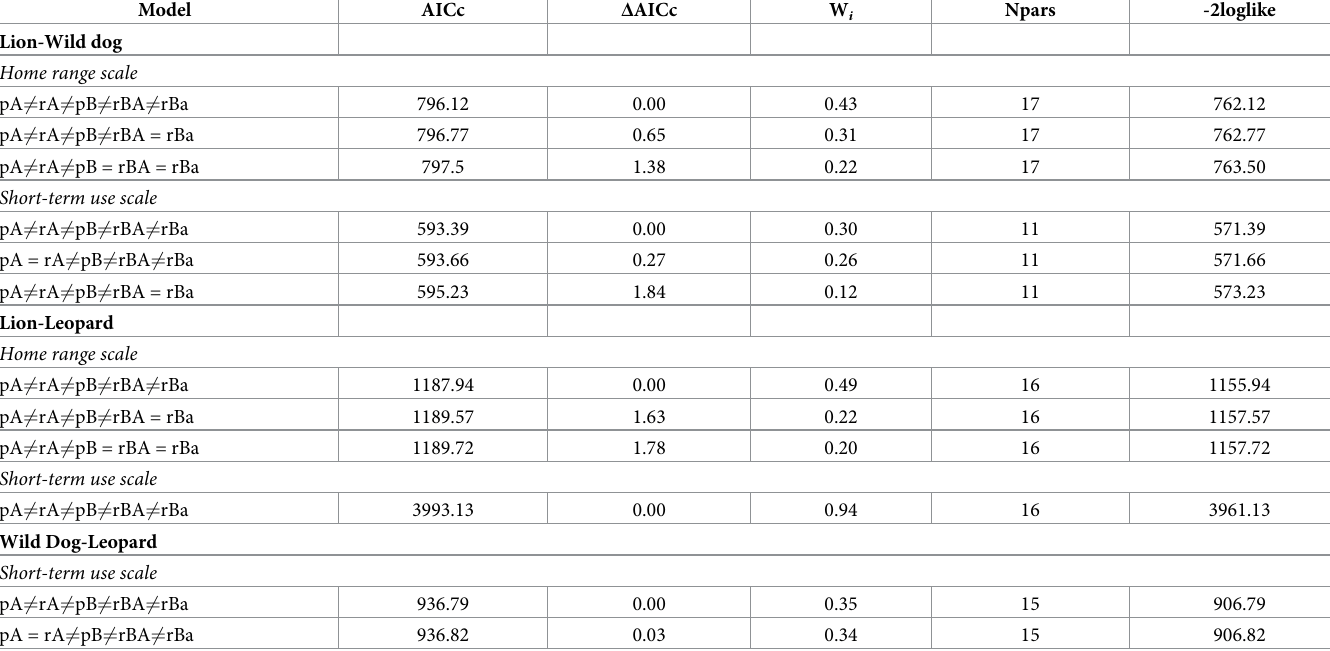
Table 3. Summary of co-occurrence model rankings used to evaluate the role of interspecific interactions on detection of three sympatric large carnivores (lion, leopard, and wild dog) in Ruaha-Rungwa, at two spatial scales (see main text for additional details). Only models with strong support (i.e. Δ AICc < 2) are presented; for full model rankings see S2